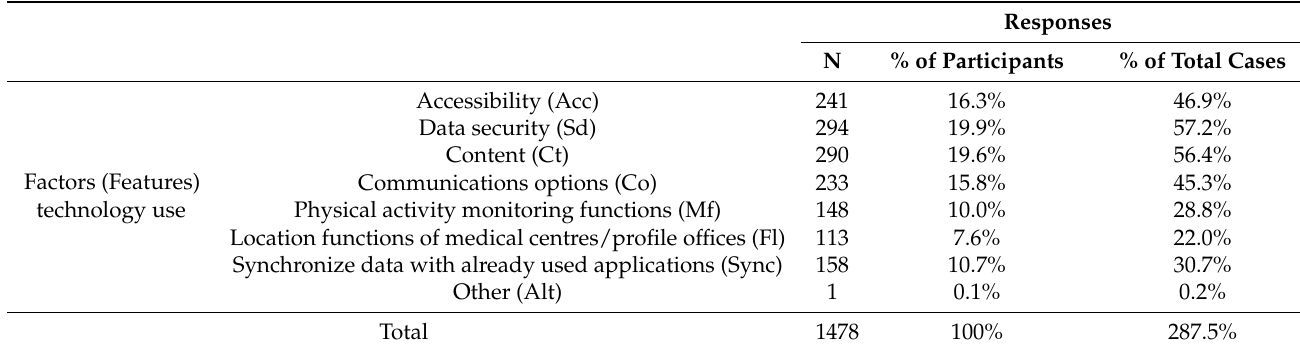
Table 3. The importance of technology tool features.